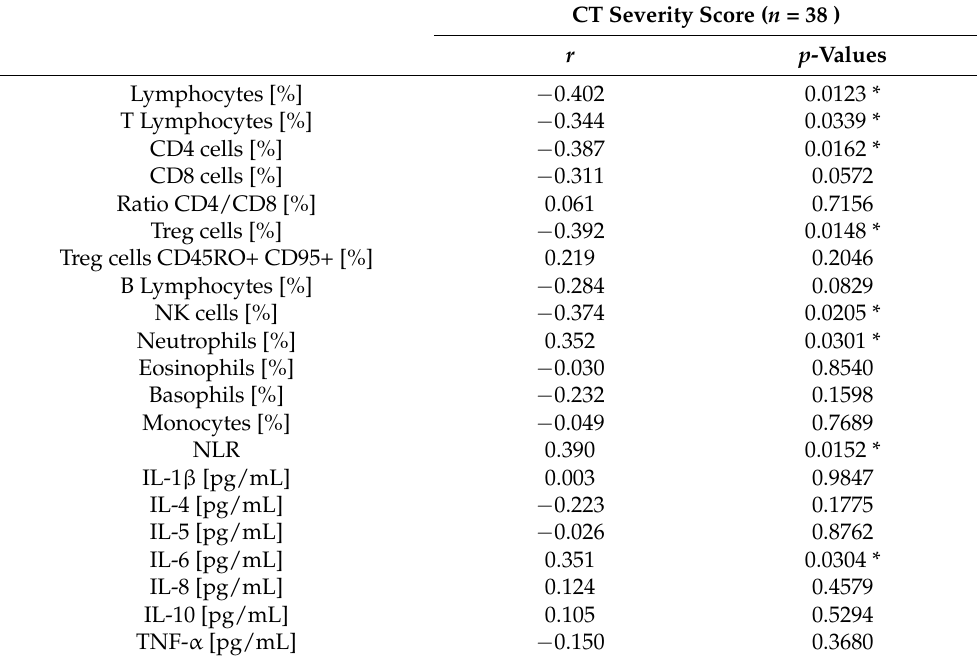
Table 4. Spearman rank correlation coefficients between CT severity score and laboratory data: leukocytes subpopulation and cytokines. * Means p <